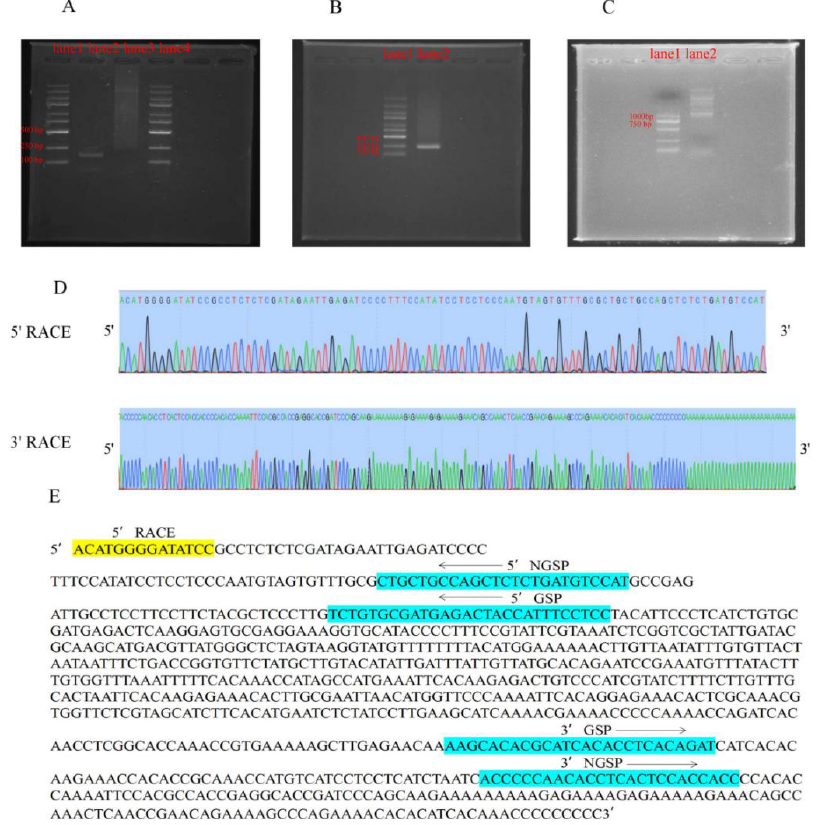
Figure 8. The results of 3 (cid:48) RACE and 5 (cid:48) RACE of SVR. ( A ) Strand-specific amplification of SVR using 3 (cid:48) RACE cDNA fragments. 3 (cid:48) NGSP-forward primer (presented in ( E )) with UPM was used to obtain 3 (cid:48) end products, which are presented in lane 2. Lane 1: DNA marker M5000. Lane 3: positive control. ( B ) Strand-specific amplification of SVR using 5 (cid:48) RACE cDNA fragments. 5 (cid:48) NGSP-reverse primer (presented in ( E )) with UPM was used to obtain 5 (cid:48) end products, which are presented in lane 2. Lane 1: DNA marker M5000. ( C ) Strand-specific amplification of full-length cDNA of SVR with 5 (cid:48) -end primers and 3 (cid:48) -end primers, which are presented in lane 2. Lane 1: DNA marker M2000. ( D ) Peak diagram of 3 (cid:48) RACE products and 5 (cid:48) RACE products. The 3 (cid:48) RACE products and 5 (cid:48) RACE products of SVR were characterized by sequencing. ( E ) Sequence of the predicted SVR. The 5 (cid:48) RACE sequences are indicated in yellow, and 3 (cid:48) RACE sequences are not indicated for the same to RNA-Seq sequences. The 5 (cid:48) NGSP (nested gene specific primer) and GSP (gene specific primer) are indicated in blue, the 3 (cid:48) NGSP and GSP are also indicated in